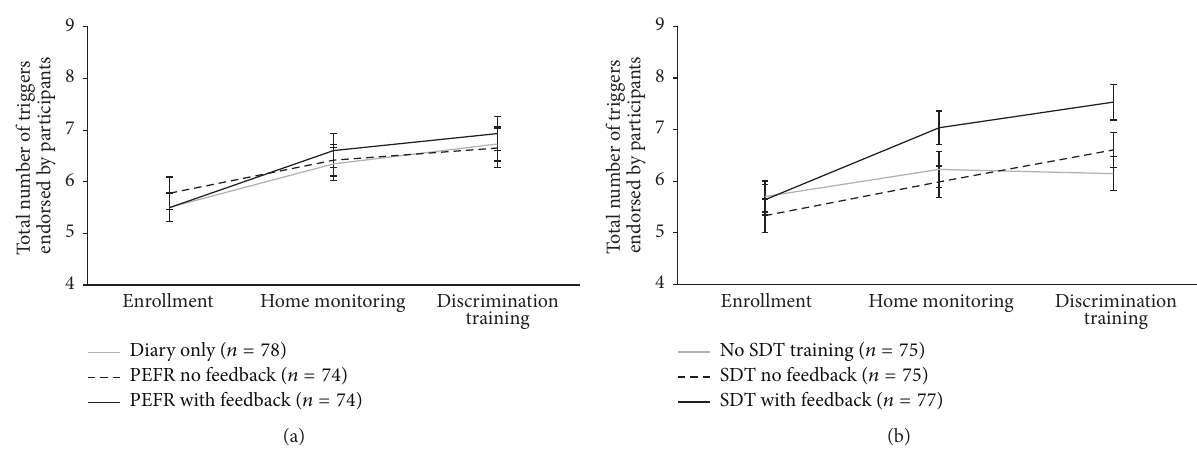
Figure 2: Total number of reported asthma triggers (mean ± SEM) for each home monitoring condition (a) and for each resistive load signal detection training (SDT) condition (b) at enrollment, after home monitoring, and after discrimination